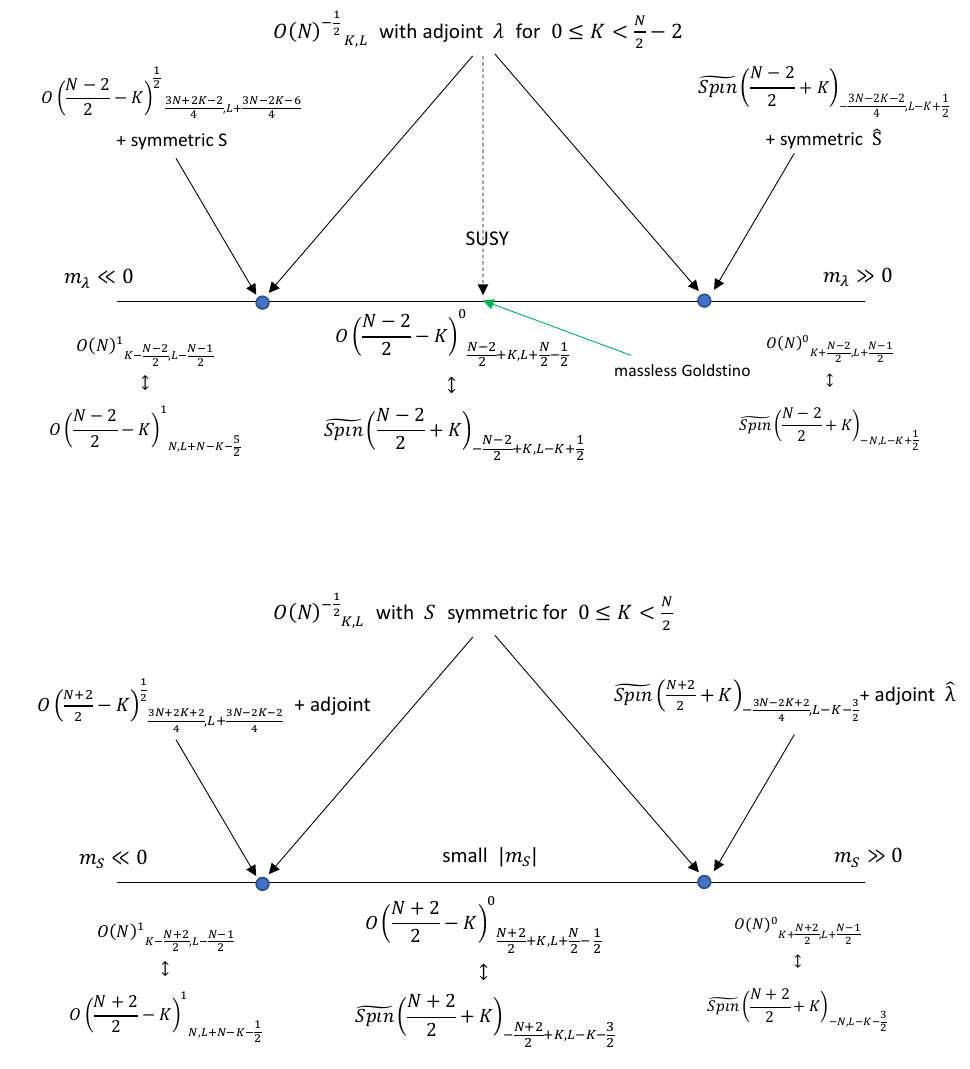
1 2 gauge theory coupled tensor fermions. The (cid:93) Spin ( N ) is explained around K , L